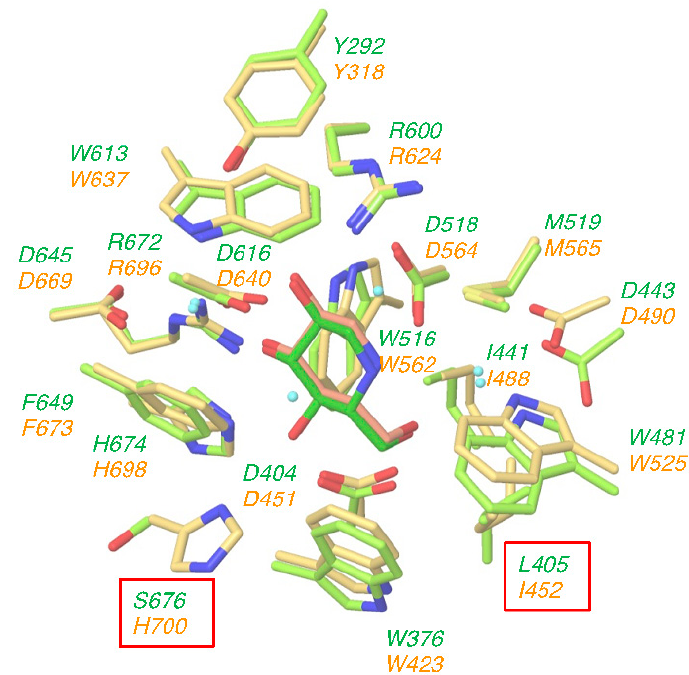
Figure 2. Structural overlap of lysosomal acid α -glucosidase (GAA) (light green) and endoplasmic reticulum (ER) α -glucosidase II (yellow) at the deoxynojirimycin (DNJ) binding site. Upper light green: amino acid residues of GAA. Lower yellow: amino acid residues of ER α -glucosidase II. Amino acid in a box: uncommon amino acid residues.